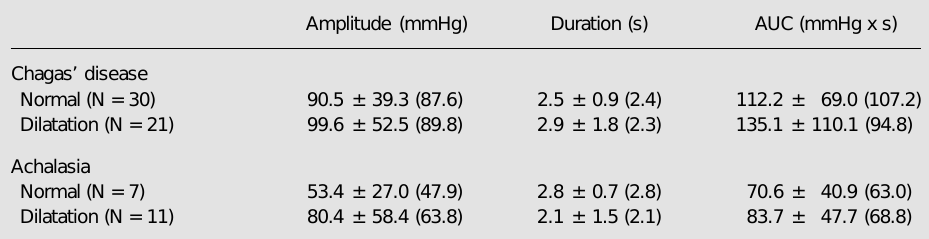
Table 2. Esophageal striated muscle contractions of patients with Chagas’ disease and idiopathic achalasia with normal esophageal diameter or with esophageal